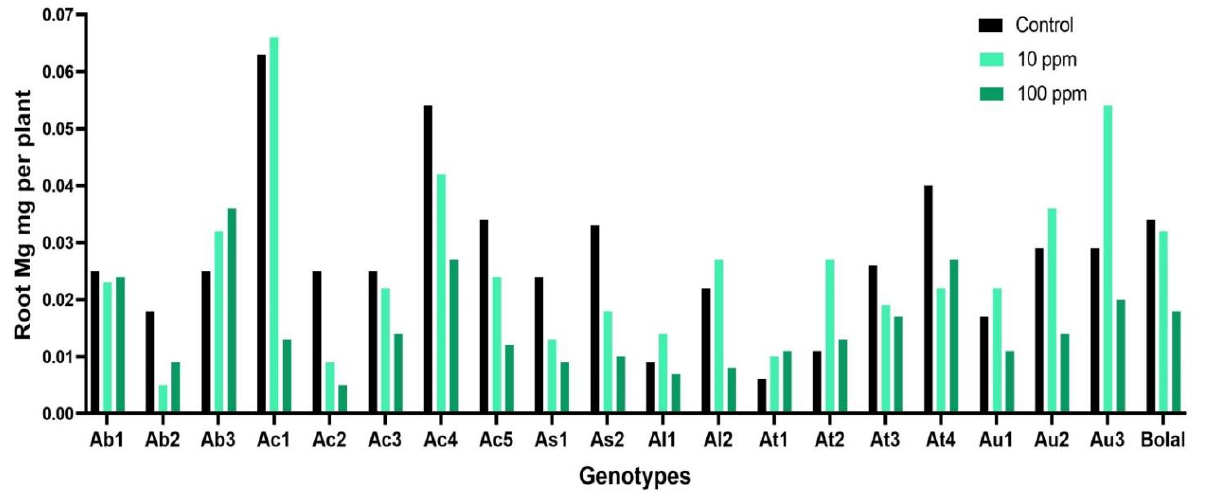
Figure 4. Variation in the RMg (root magnesium) uptake of 19 Aegilops genotypes and Bolal 2973, the B tolerant check genotype, in Control (3.1 μM B), 10 ppm B (toxic B) , and 100 ppm B (highly toxic B).